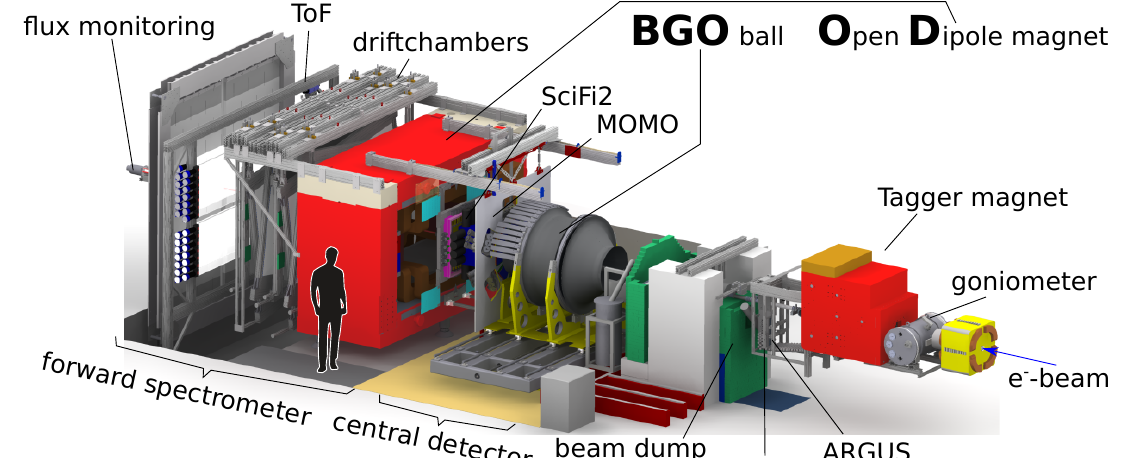
Figure 2. Overview of the BGO-OD